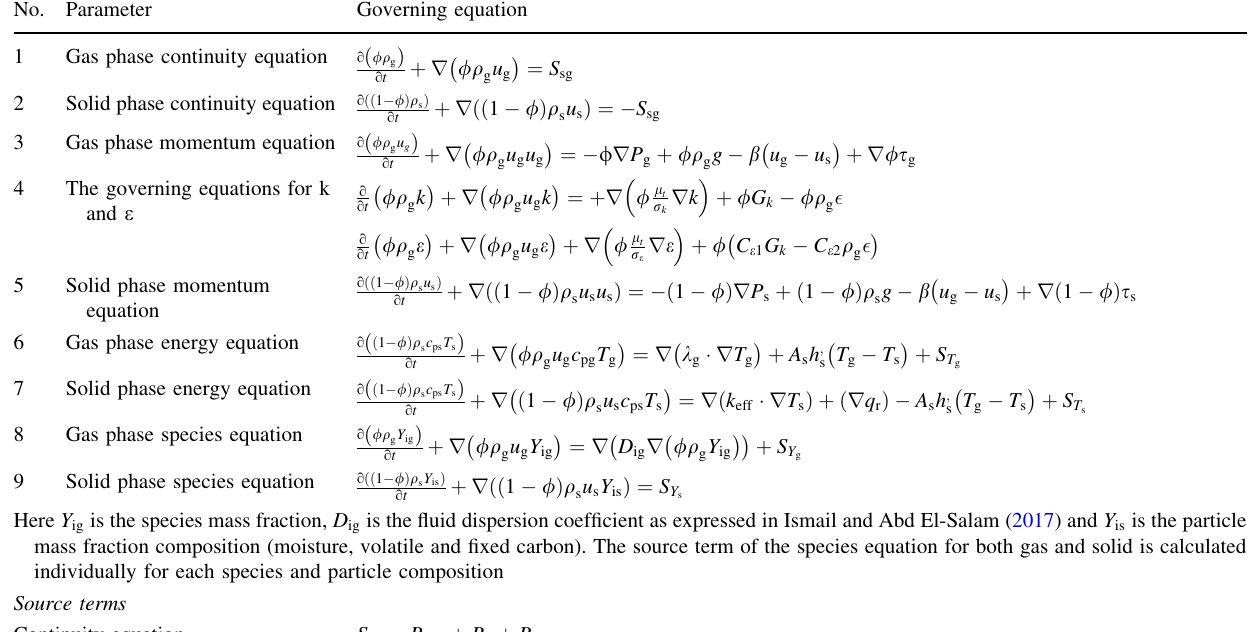
Table 7 Governing equations (Kader 1981; Gupta et al. 2003) No. Parameter